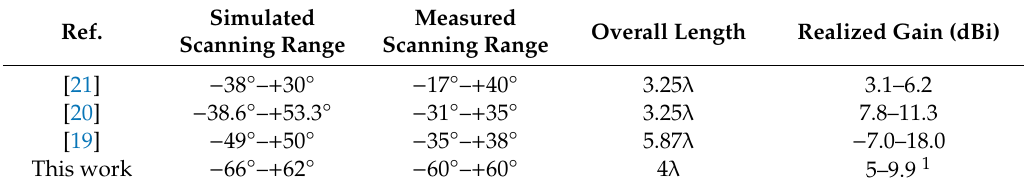
Table 3. Comparison of electronically controlled composite right/left-handed (CRLH) LWAs. Ref.